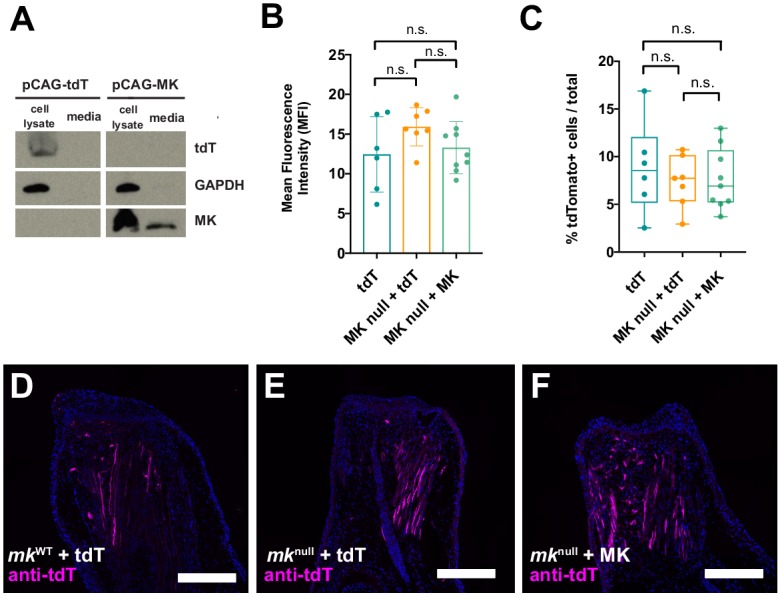
Electroporation efficiencies are similar between pCAG-tdTomato and pCAG-MK injected mknull mutant and mkWT regenerating limbs.(A) Validation of pCAG-MK overexpression construct with MK antibody. Western blots of either pCAG-tdTomato or pCAG-MK transfected 293 T cells with the custom axolotl-MK antibody reveals the overexpression and secretion of axolotl MK in pCAG-MK, but not pCAG-tdTomato (tdT), transfected cell lysates and media. (B–C) Quantification of mean fluorescence intensity and the percentage of tdTomato+ expressing cells out of total DAPI+ cells in the distal-most 500 µm of regenerating tissue at 10 dpa. (D–F) Representative images of anti-tdTomato-stained sections from each condition. One-way ANOVA analyses were employed on each set of data for statistical analysis (N = 7 mkWT + tdT, 7 mknull+tdT, 9 mknull + MK). Scale bars, 500 µm. dpa, days post-amputation, n.s. not significant.